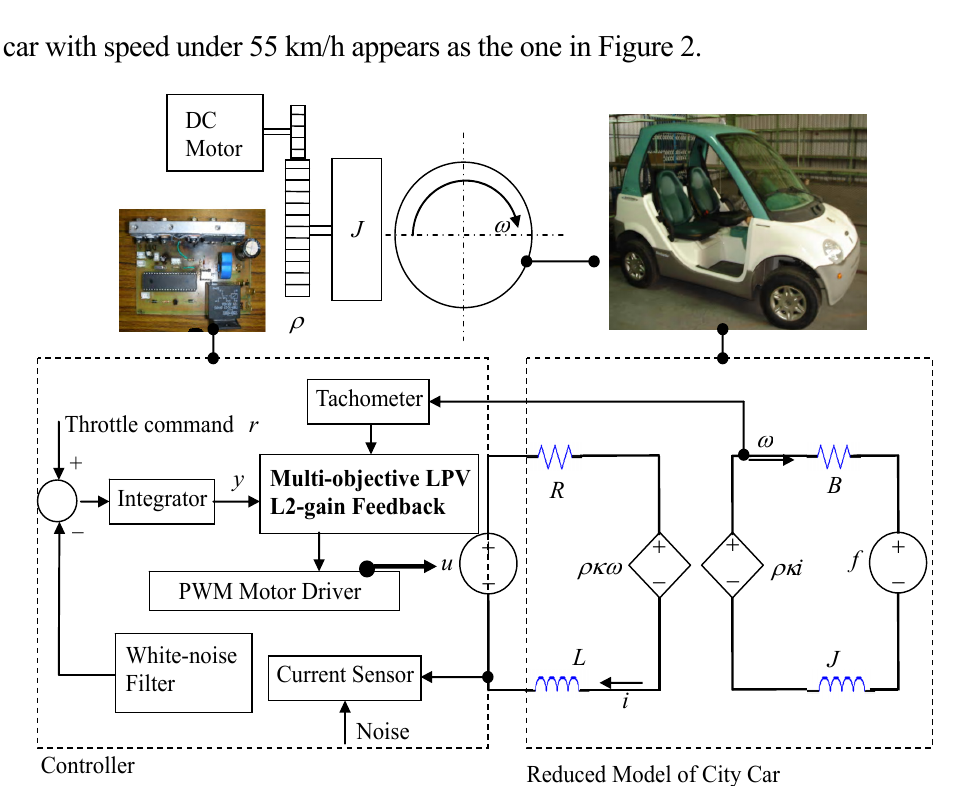
Figure 2. Modeling and controller design of DC-motorized city